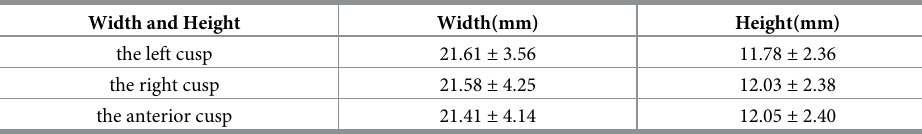
Fig 2. A schematic plot of the human pulmonary valve. (a) is the pulmonary valve during diastole (cf. [15]) and (b) is the pulmonary valve during systole (cf. [18]) (c) is the expanded semilunar valve. A: anterior leaflet, L: left leaflet, R: right leaflet. https://doi.org/10.1371/journal.pone.0199390.g002 Table 1 shows the literature values for the widths and the heights of the cusps of the pulmo- nary valve [19]. The height refers to the distance from the free edge of the pulmonary valve to its attachment midpoint, and the width refers to the distance between the pedicles. The right semilunar valve is deemed as a portion of the cylinder shell [20] which is cut along the major axis of the xy plane (Fig 3). We have to determine the valve of every coefficient including r and h , and the range of every variable including θ and z (see Appendix), to fit the shape of the right valve. In fact, the size of the pulmonary valves is different based on individ- ual variation, so we give an approximate value, that is take the width of the semilunar valve as Table 1. The width and height in millimeters of the pulmonary valve